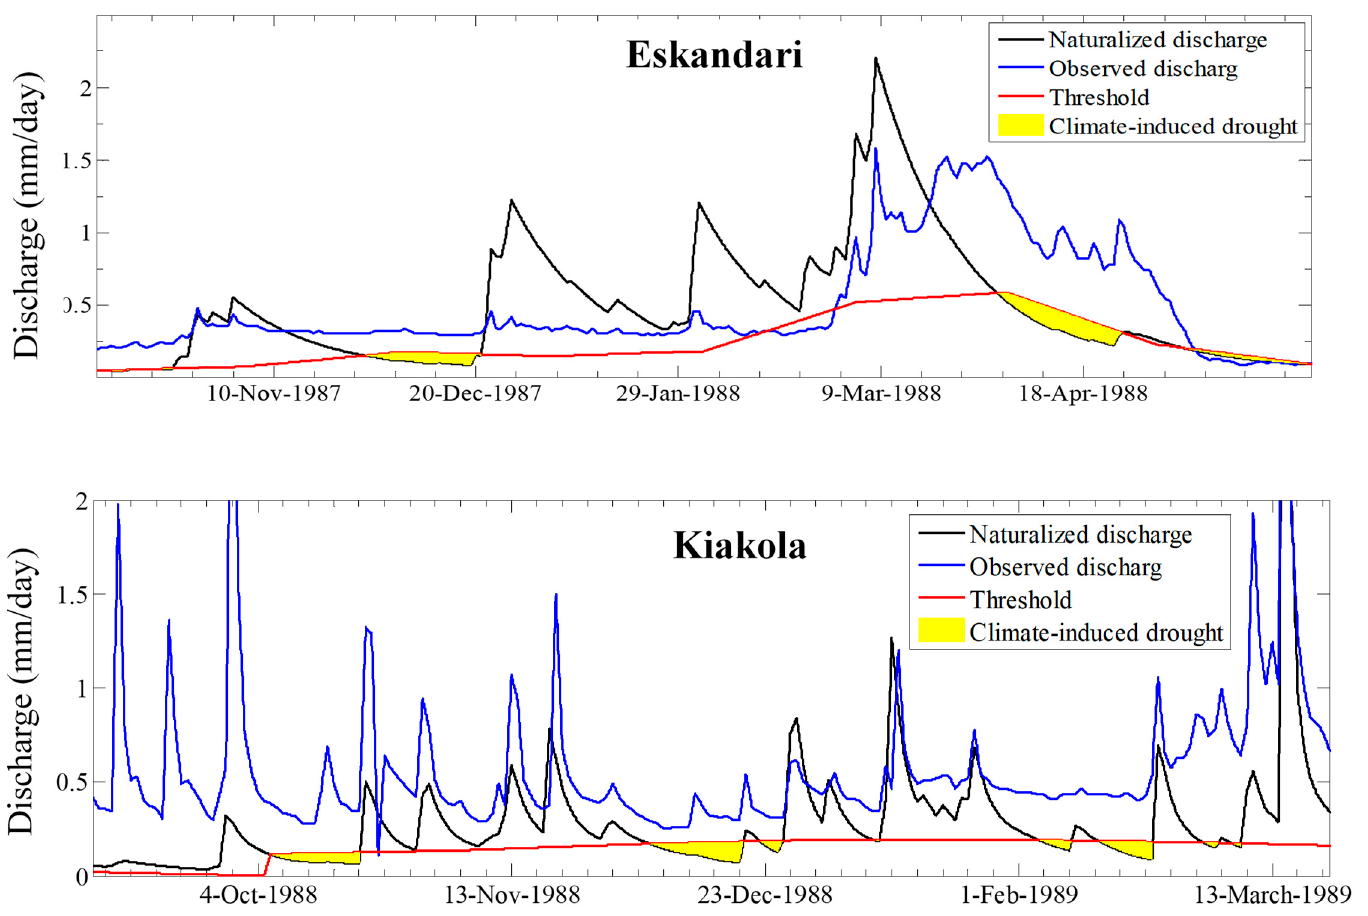
Figure 8. Examples of climate-induced droughts.